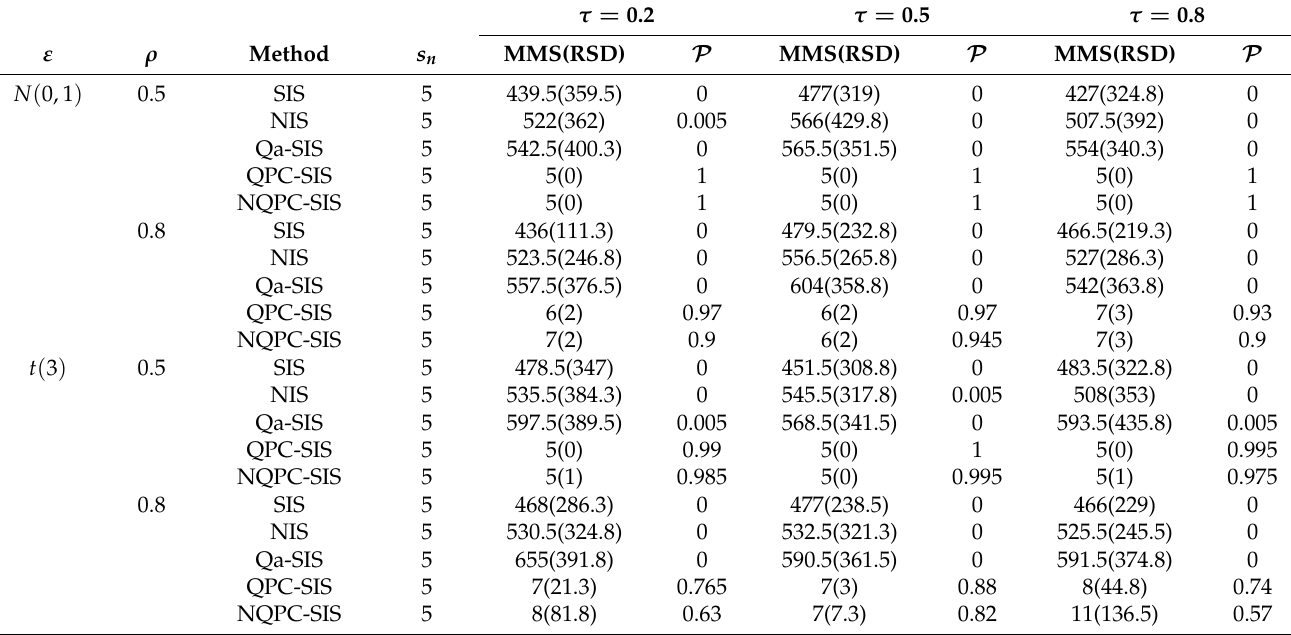
Table 2. Simulation results for Example 2 when n =